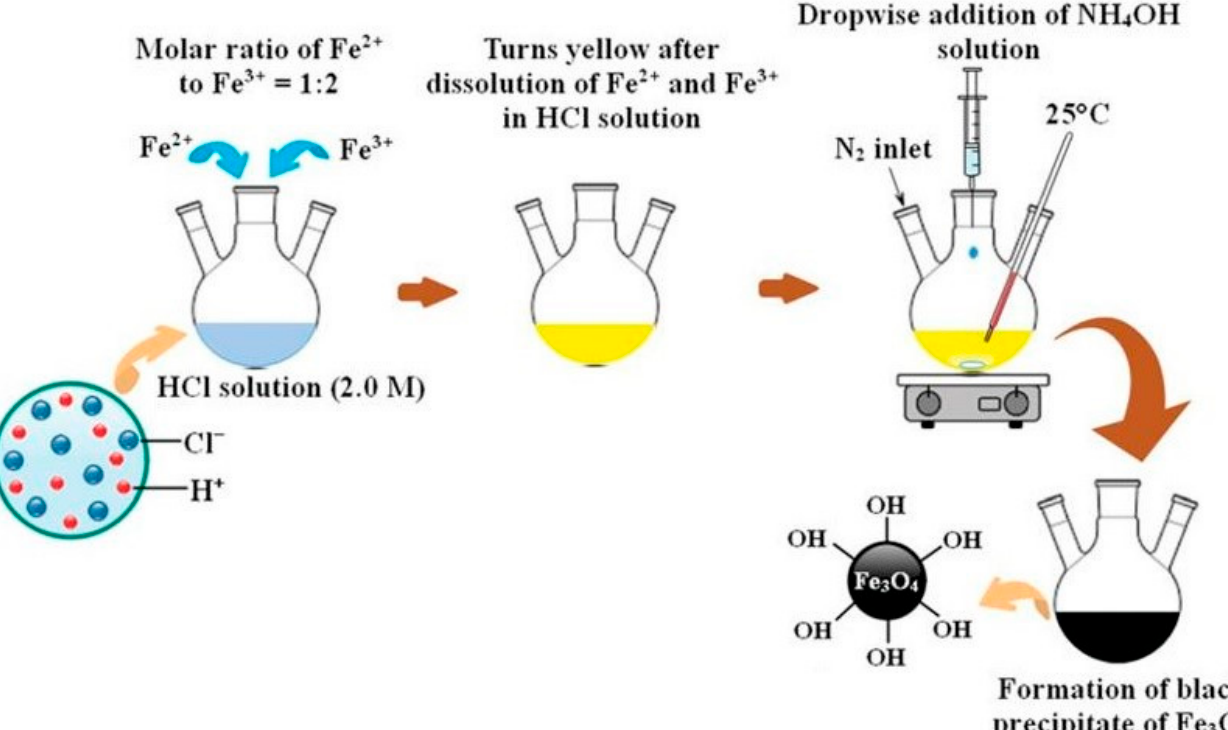
Figure 2. Schematic representation of magnetite synthesis by co-precipitation method (adapted from [44] with permission from the Taylor & Francis Group).